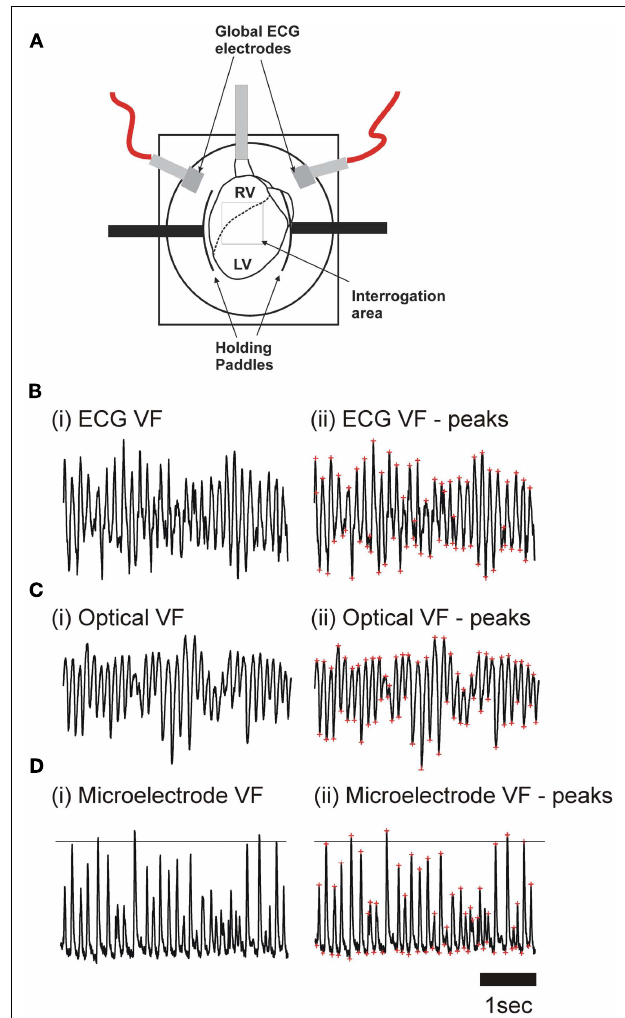
FIGURE 1 | (A) Langendorff-perfused rabbit heart in optical mapping chamber.The superimposed grid represents the area of the myocardium (16 × 16 pixel) visualized by the photodiode array. (B) ECG recording during (i) ventricular fibrillation (VF), and (ii) VF with peaks identified (red asterisks). (C) Optical pixel recordings from LV epicardium during (i) inVF, and (ii) inVF with peaks identified (red asterisks). (D) Transmembrane recordings of the LV epicardium during (i) inVF, and (ii) VF with systolic and diastolic peaks